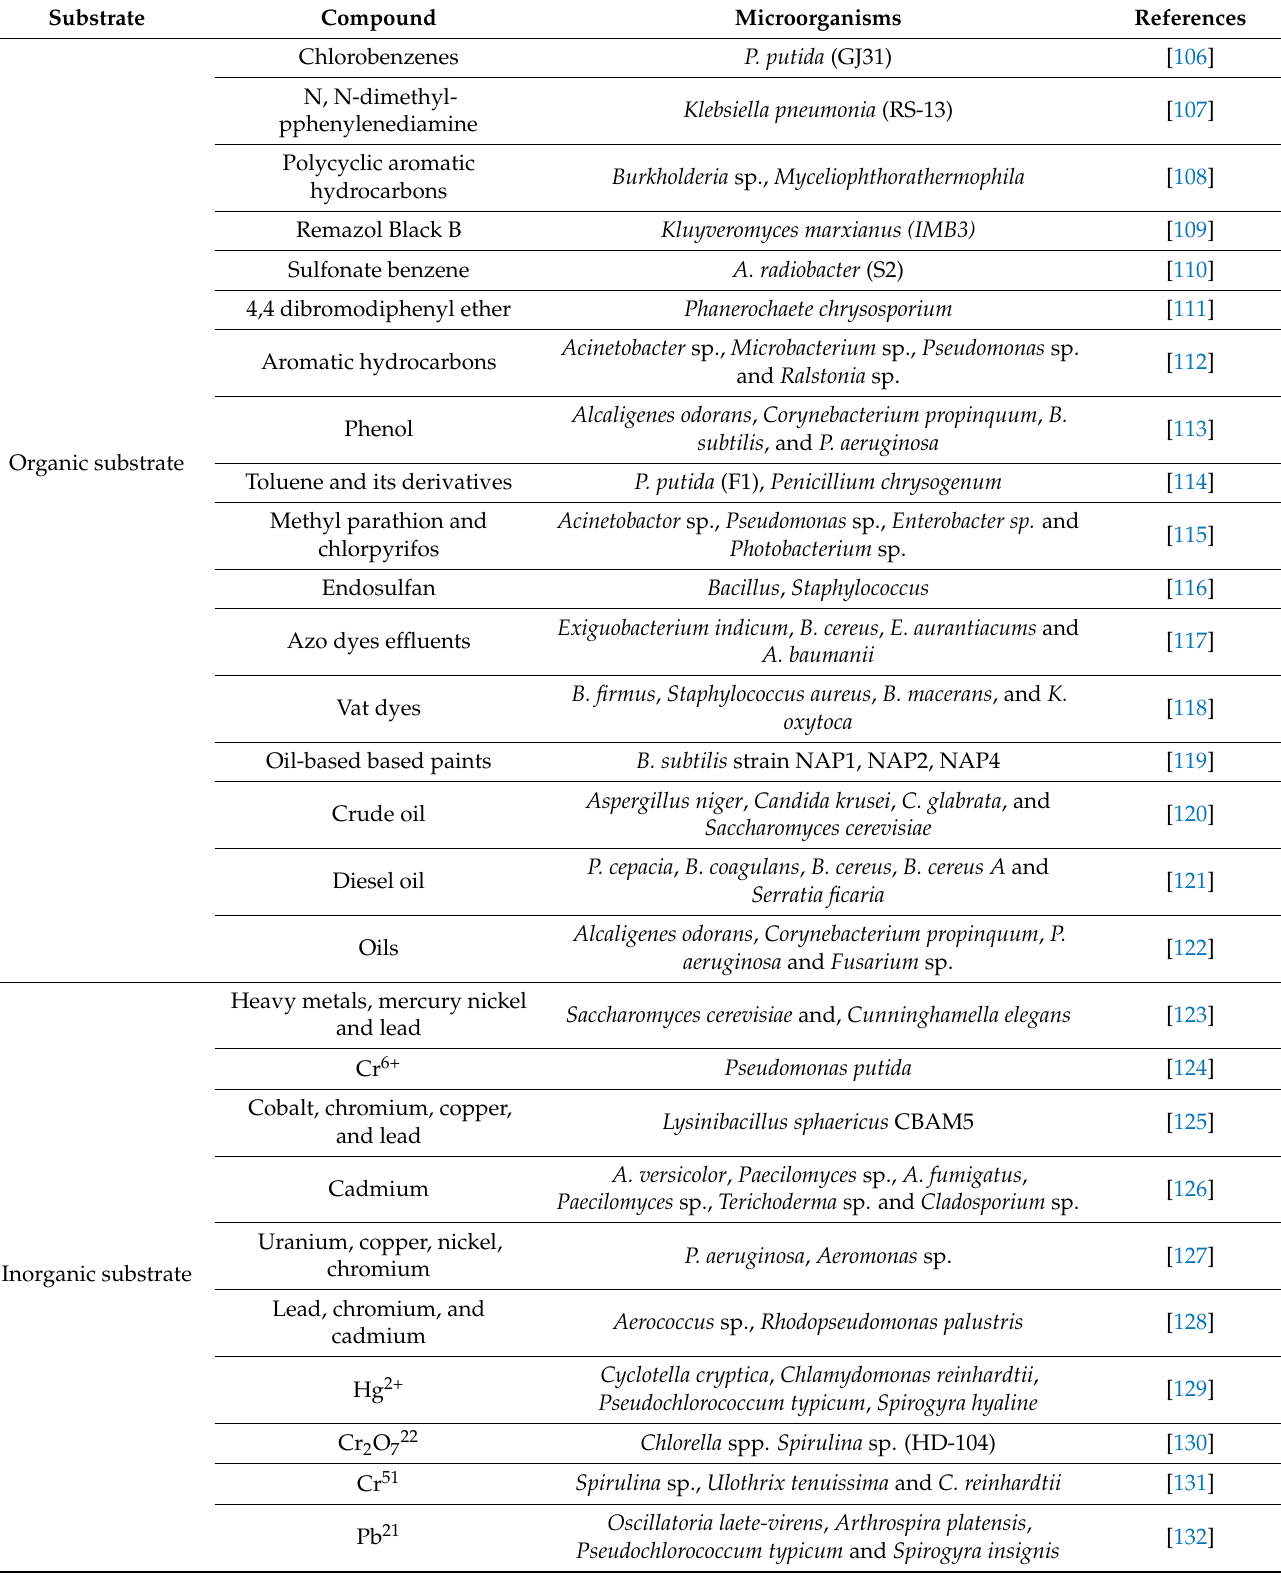
Table 3. Potentially hazardous organic and inorganic pollutants and their degrading microbes (bacteria, fungi, and